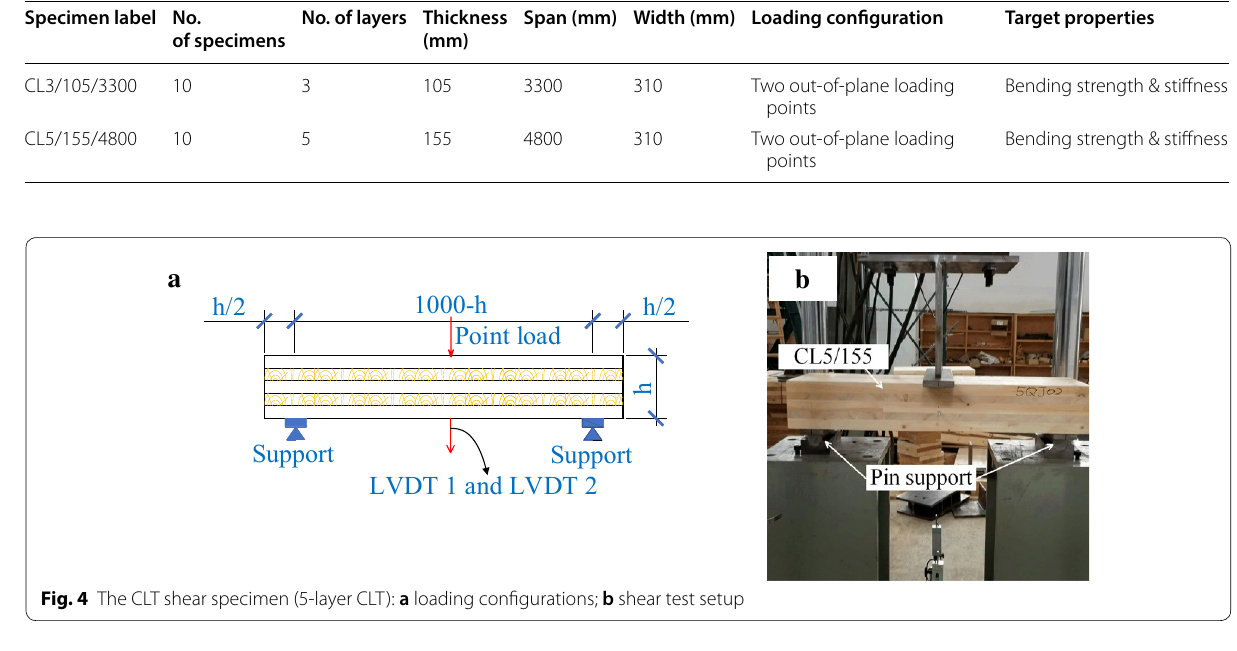
No. of layers Thickness of specimens (mm)